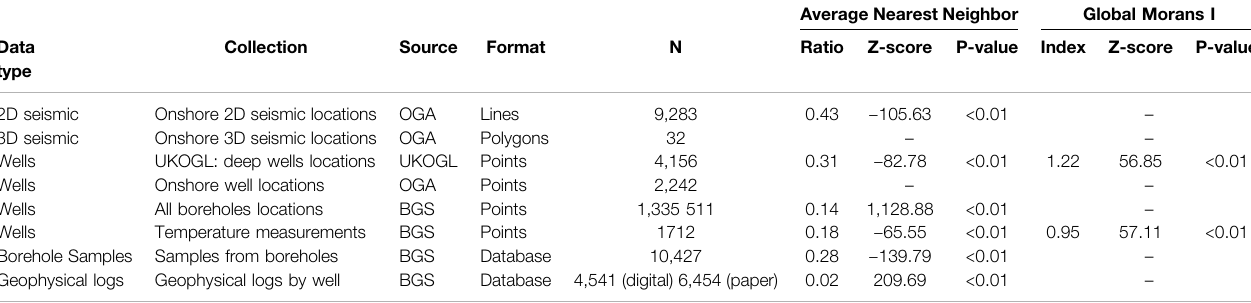
TABLE 2 | Data sources used in the quantitative analysis of available data onshore the United Kingdom and associated spatial